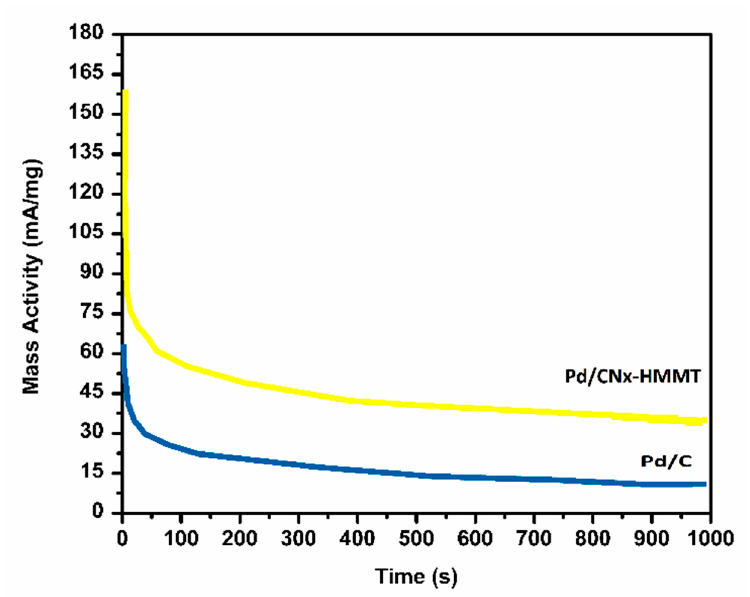
Figure 8. Chronoamperometric data of Pd/C and Pd/CNx-HMMT MOR electrocatalysts.